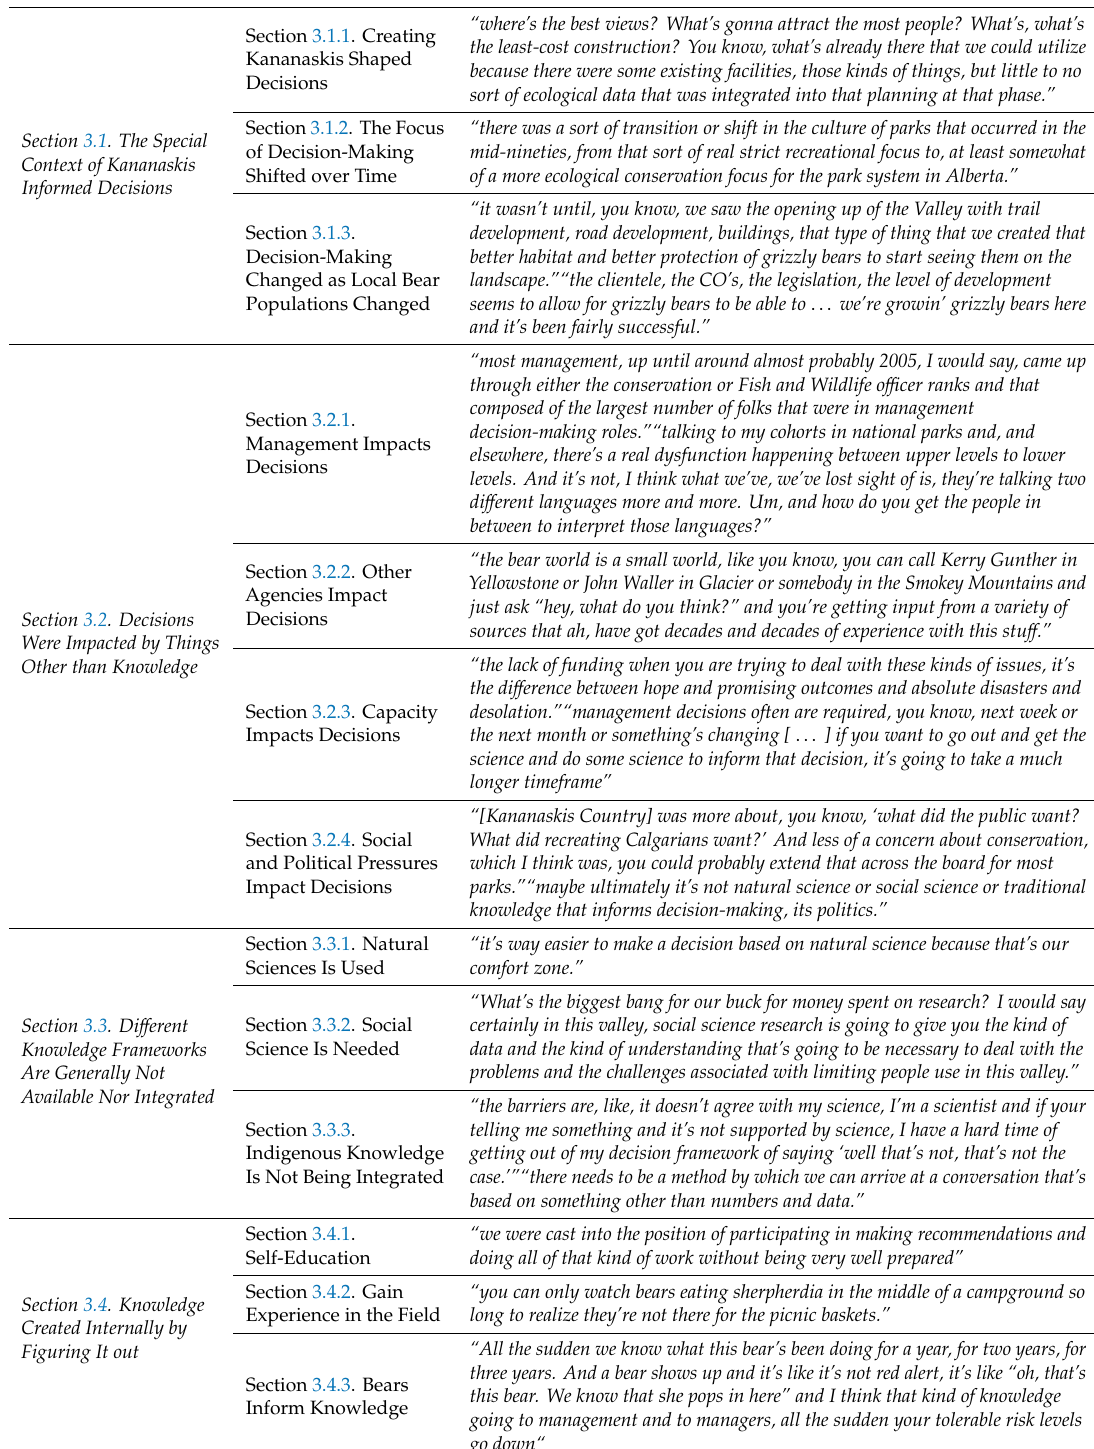
Table 3. Themes and Sub-Themes. Representative quotes are provided to illustrate the kinds of statements shared by participants in each